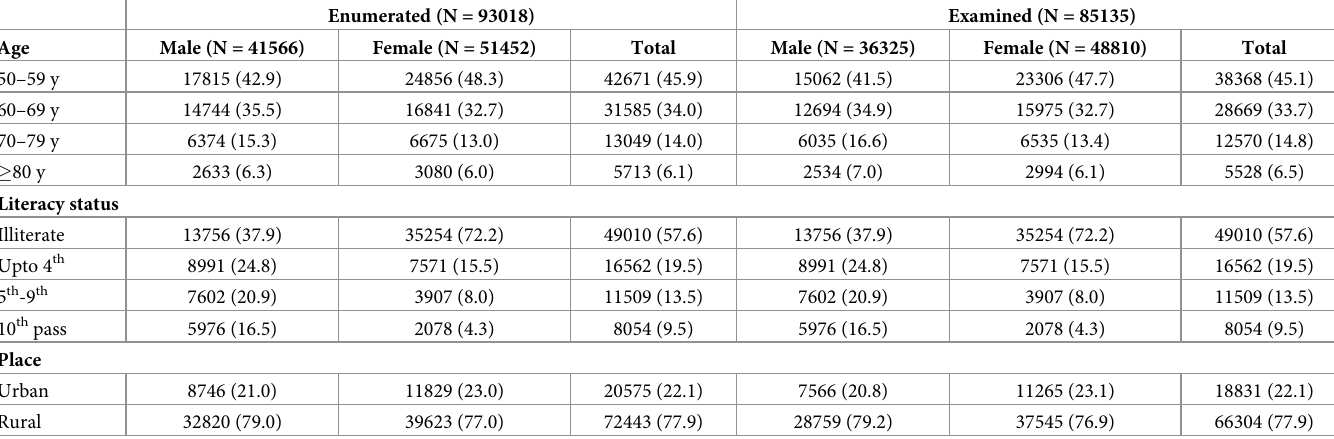
Table 2. Socio-demographic profile of study participants aged � 50